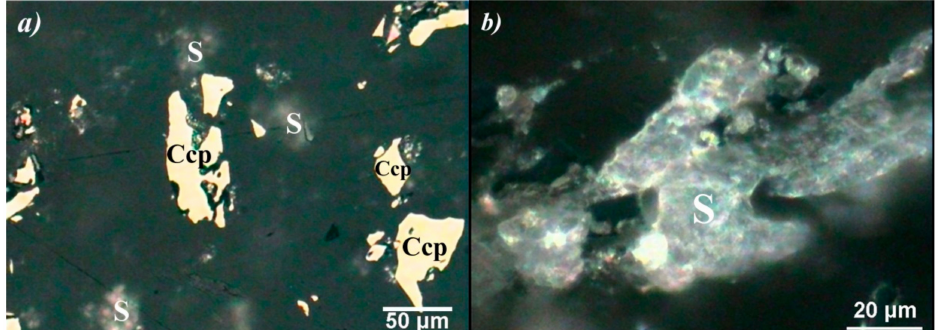
Figure 8. Optical micrograms of the leach residue for di ff erent temperatures of leaching (particle size − 37 µ m, stirring speed—100 rpm, time—240 min, solid / liquid ratio—2 g / dm 3 , —1.5 M H H 2 O 2 ): ( a ) temperature 25 ◦ C, ( b ) temperature 40 ◦